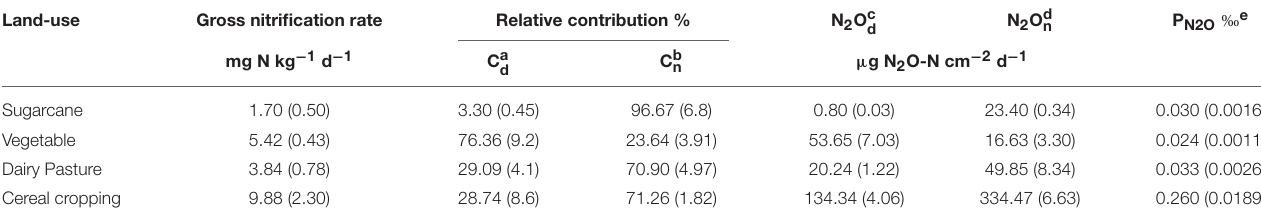
TABLE 2 | Gross nitrification rates and the ratios of N 2 O production to nitrification in the studied agricultural soils. Land-use